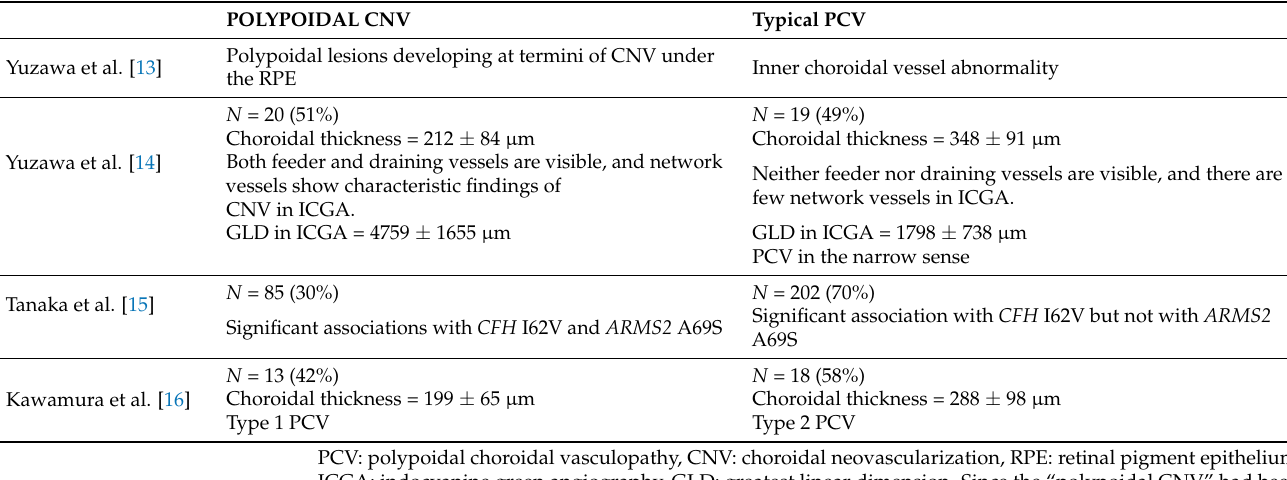
Table 1. Definition and characteristics of proposed typical PCV and POLYPOIDAL CNV.